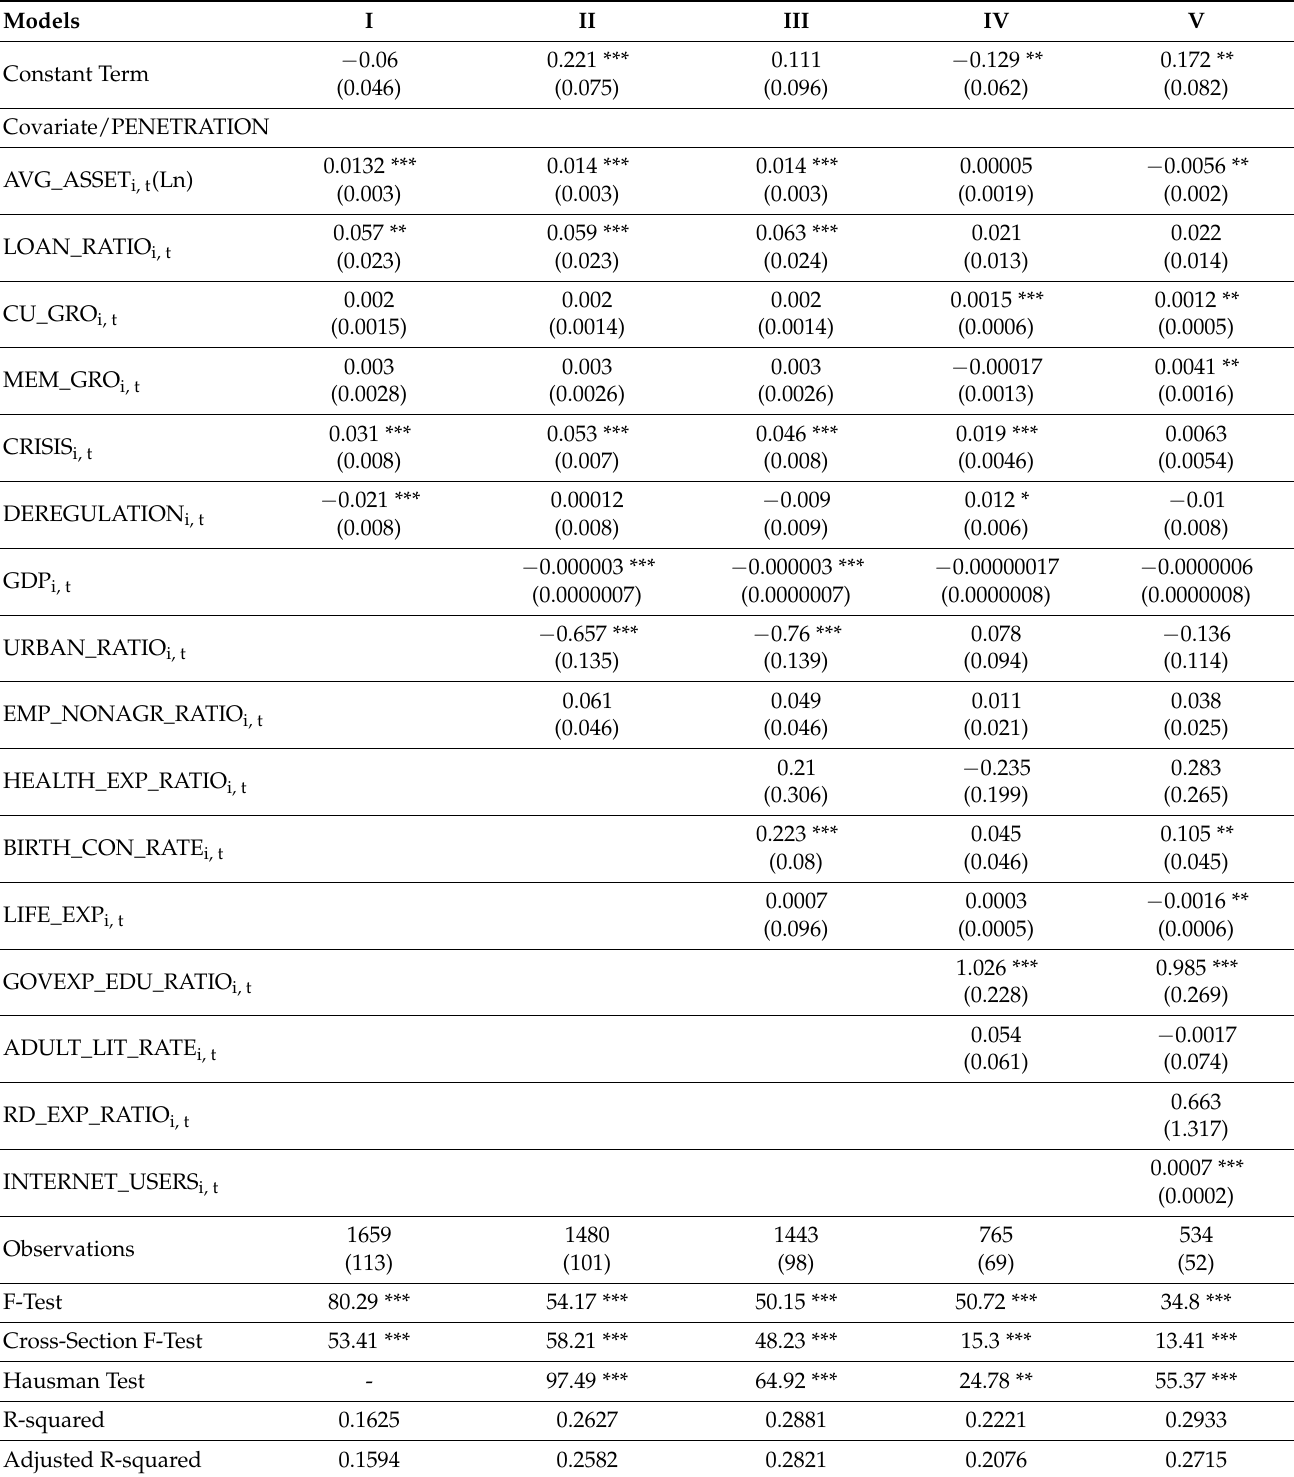
Table 9. Models’ estimation